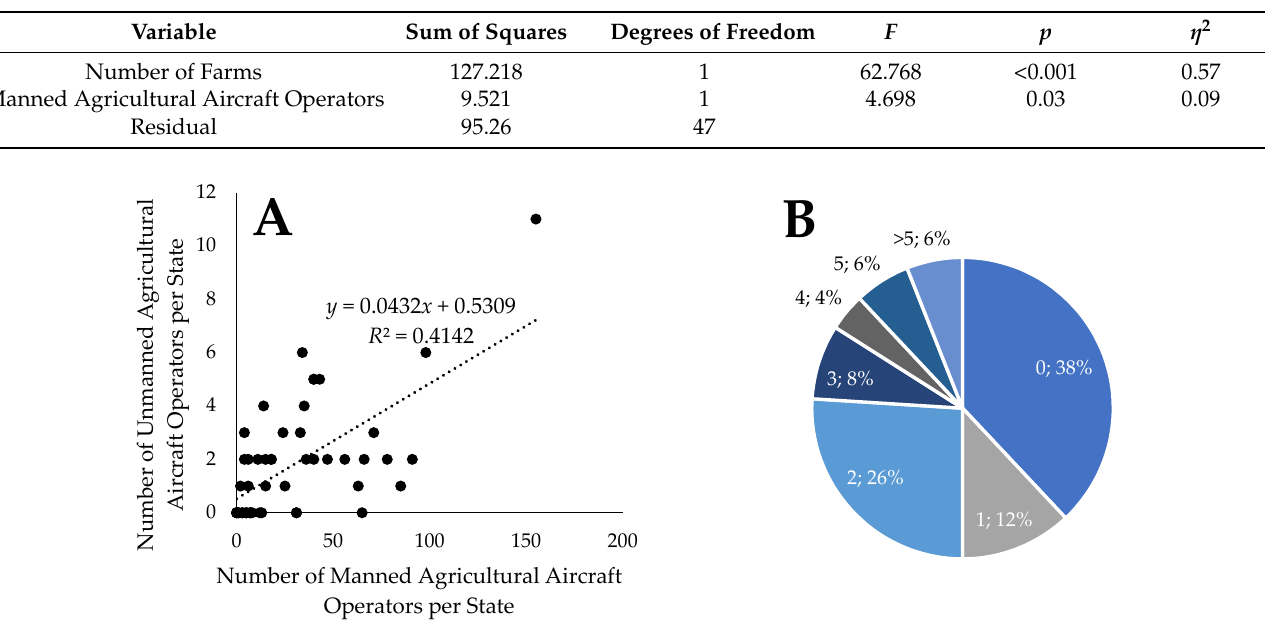
Figure 4. ( A ) Number of unmanned agricultural aircraft operators vs number of manned agricultural aircraft operators. ( B ) Number of unmanned agricultural aircraft operators by state.